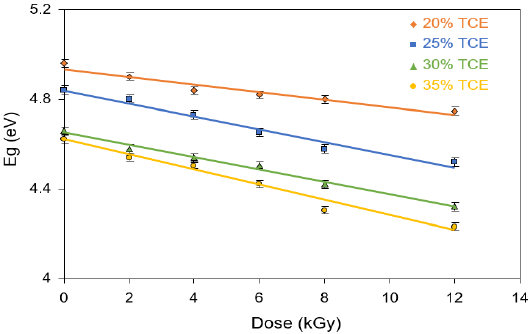
Figure 14. Variation of the indirect energy band gaps with dose for CR dyed PVA-TCE films at different TCE compositions.